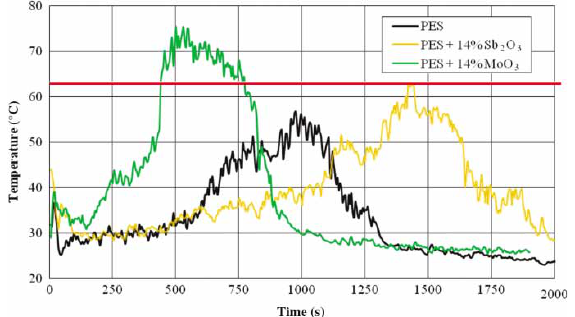
Fig. 9. Temperature curves registered by the thermocouple placed on tree 18 at a height of 1.5 m for three studied samples